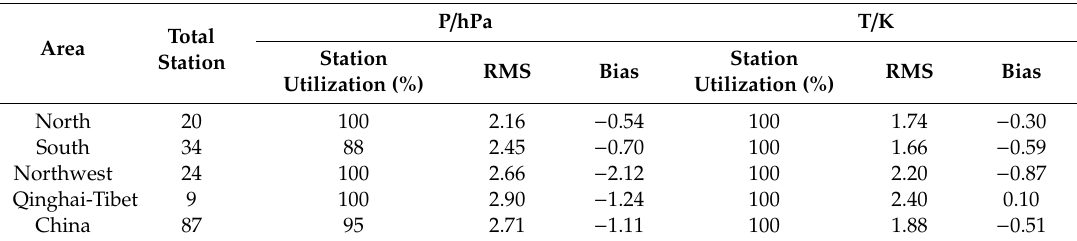
Figure 3. RMS and bias of P and T derived from ERA5 at 87 RS stations during the period 2005–2017 in China. Table 3. Statistical results of a number of RS stations used and the average RMS and bias of ERA5-derived P and T in four regions of China during the period 2005–2017.